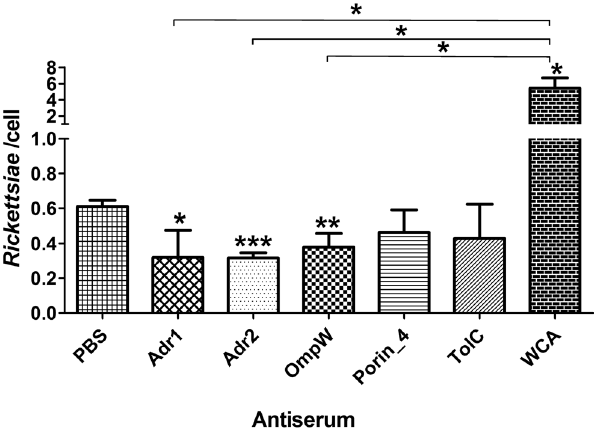
Figure 5. Neutralization of R. rickettsii by sera from mice immunized with surface-exposed proteins. Viable R. rickettsii organisms were incubated with naı¨ve serum, anti-rAdr1, -rAdr2, - rOmpW, -rPorin_4, -rTolC, or -WCA (positive control) immune serum for 60 min. After incubation, the mixture was added into EA.hy 926 cells for 6 h. The total number of R. rickettsii that adhered to and invaded the host cells was determined using R. rickettsii -specific qPCR. The results were analyzed using the T test or Wilcoxon two-sample test according to their normality and homogeneity of variance. The statistically significant differences between anti-WCA immune serum and anti- rSEPs immune serum groups were indicated by horizontal lines. The values are presented as mean 6 standard deviations ( n =3); * P , 0.05, ** P , 0.01, and *** P , 0.001.